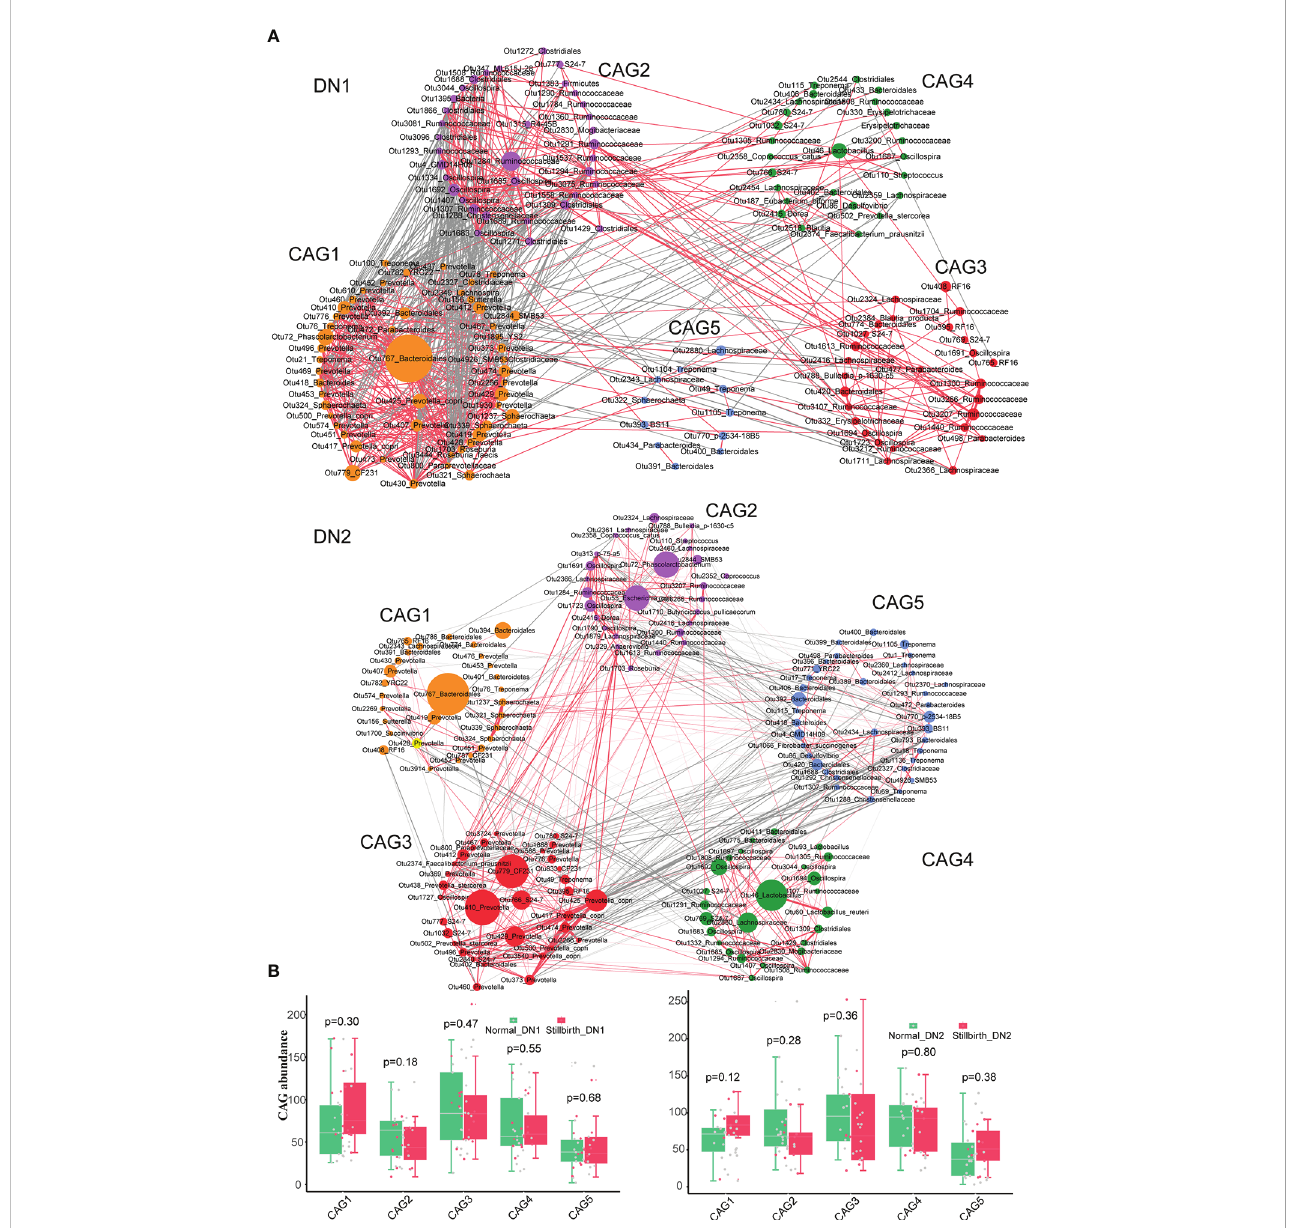
FIGURE 3 Identifying the co-abundance groups (CAGs) of gut mirobota associated with sows giving birth to stillborn piglets by co-abundance network analysis based on 16S rRNA gene sequencing data. (A) Co-abundance networks of DN1 and DN2 cohort. Each circle represents one OTU. Circles with the same color represent the OTUs from CAG. Circle size represents the average abundance of each OTU in CAGs. The red lines represent the positive correlation. And the grey lines show the negative correlation. (B) The boxplots showing the differential abundance of CAGs between stillbirth and normal sow group in the DN1 and DN2 by the Wilcoxon rank-sum